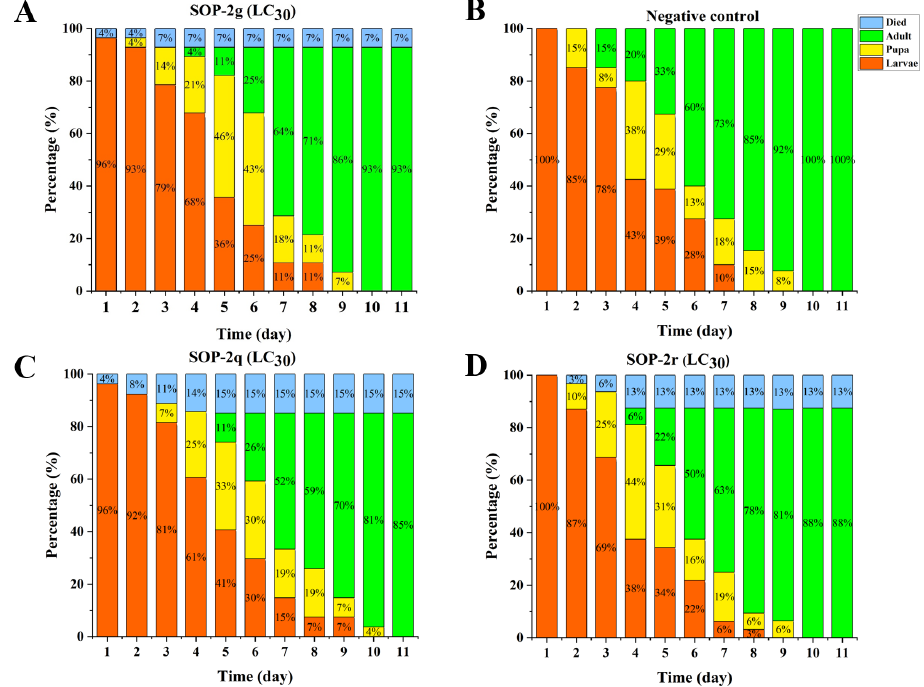
Figure 2. Effects on the emergence of larvae of Ae. albopictus : ( A ) the SOP-2g treated group; ( B ) the negative control group; ( C ) the SOP-2q treated group; ( D ) the SOP-2r treated